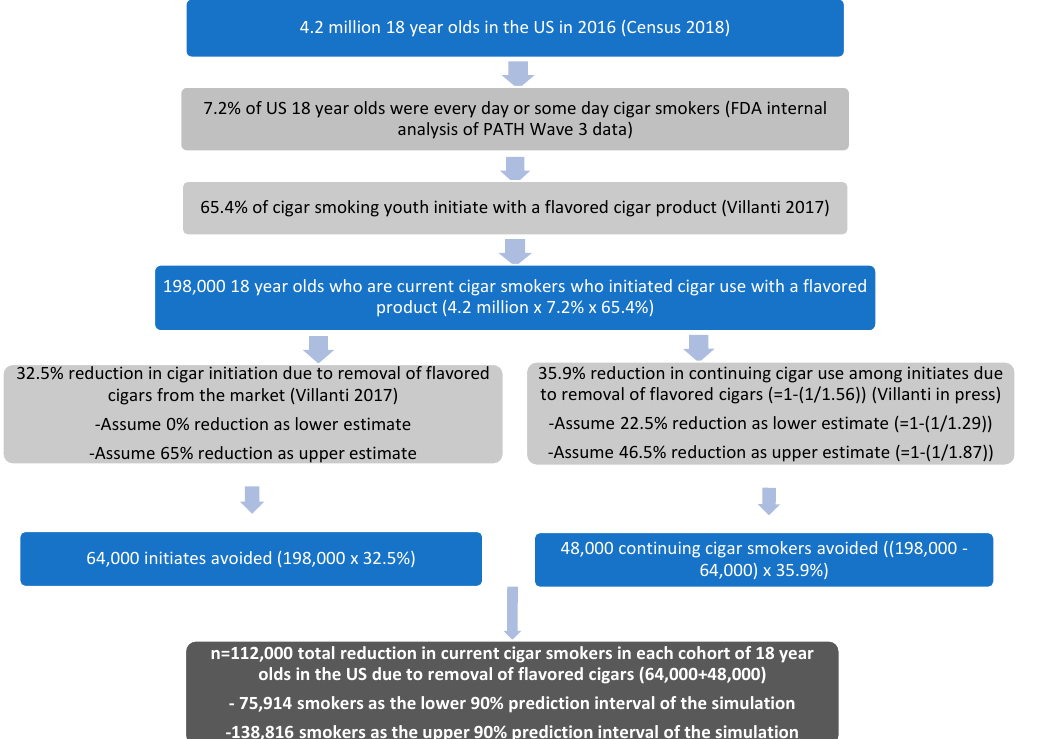
Figure 1. Calculations used to estimate the potential number of new cigar initiates and continuing cigar smokers that may be averted by policies prohibiting flavored cigars throughout the US.